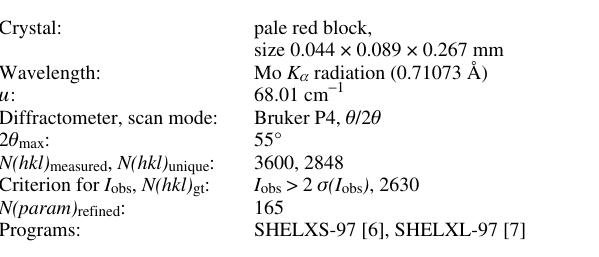
Table 1. Data collection and